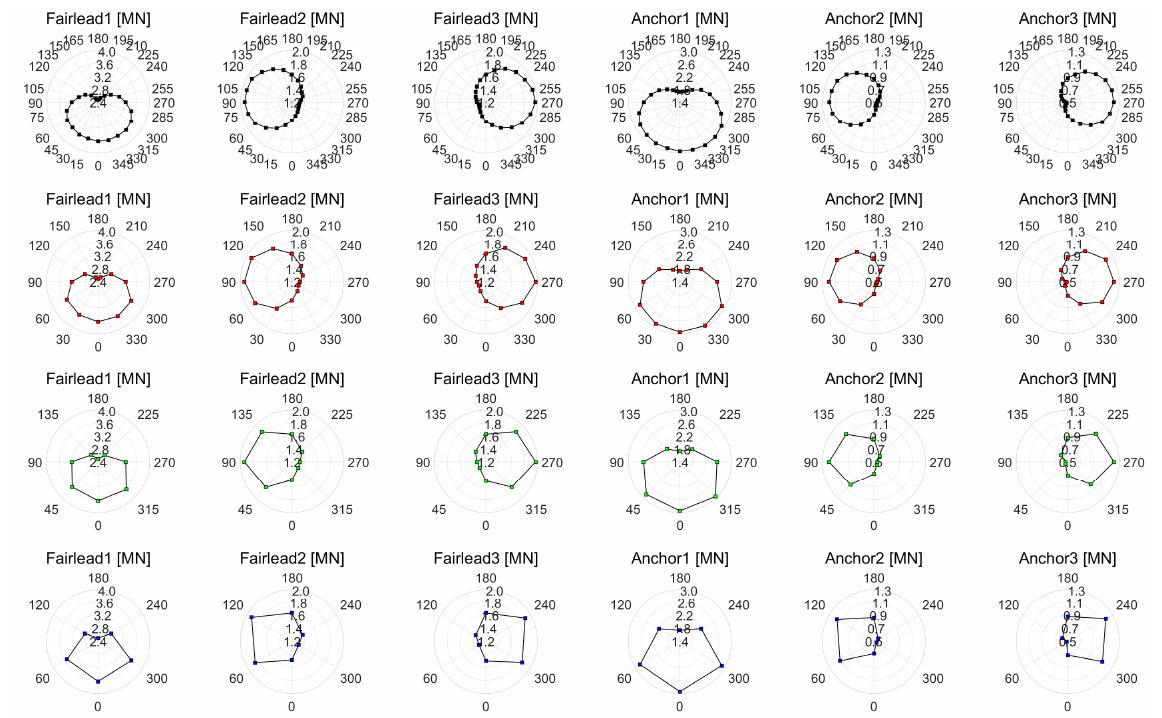
Figure 16. Maximum values of the fairlead and anchor tensions according to the interval angles.